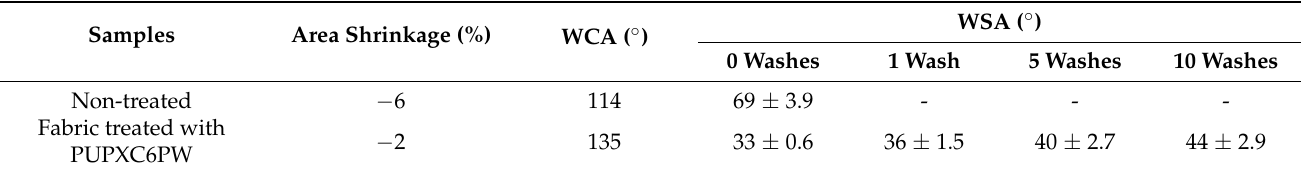
Table 4. Area shrinkage, WCA and WSA measurements of non-treated and PUPXC6PW-treated fabric.